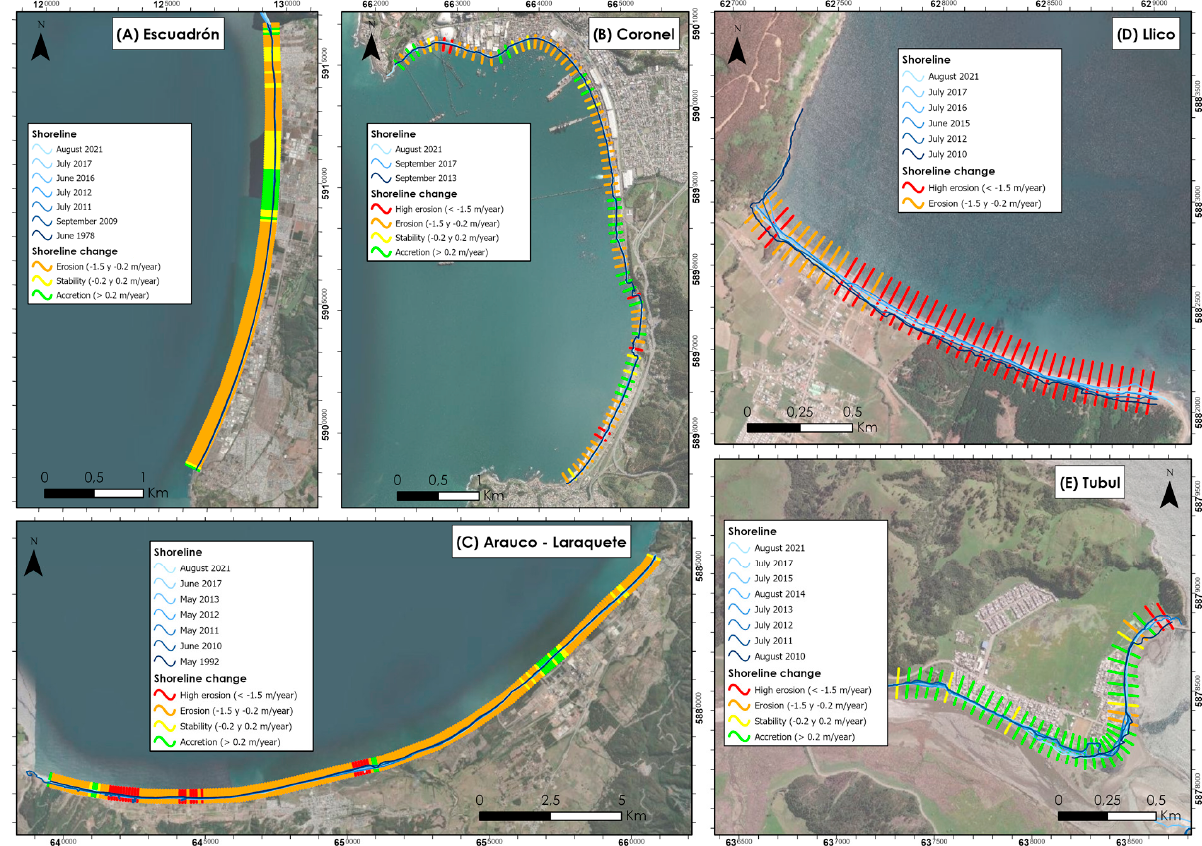
Figure 5. Spatial distribution of erosion rates on the Arauco Gulf beaches during winter. ( A ) Es- Spatial distribution of erosion rates on the Arauco Gulf beaches during cuadrón beach, ( B ) Coronel beach, ( C ) Arauco beach, ( D ) Llico beach and ( E ) Tubul beach.